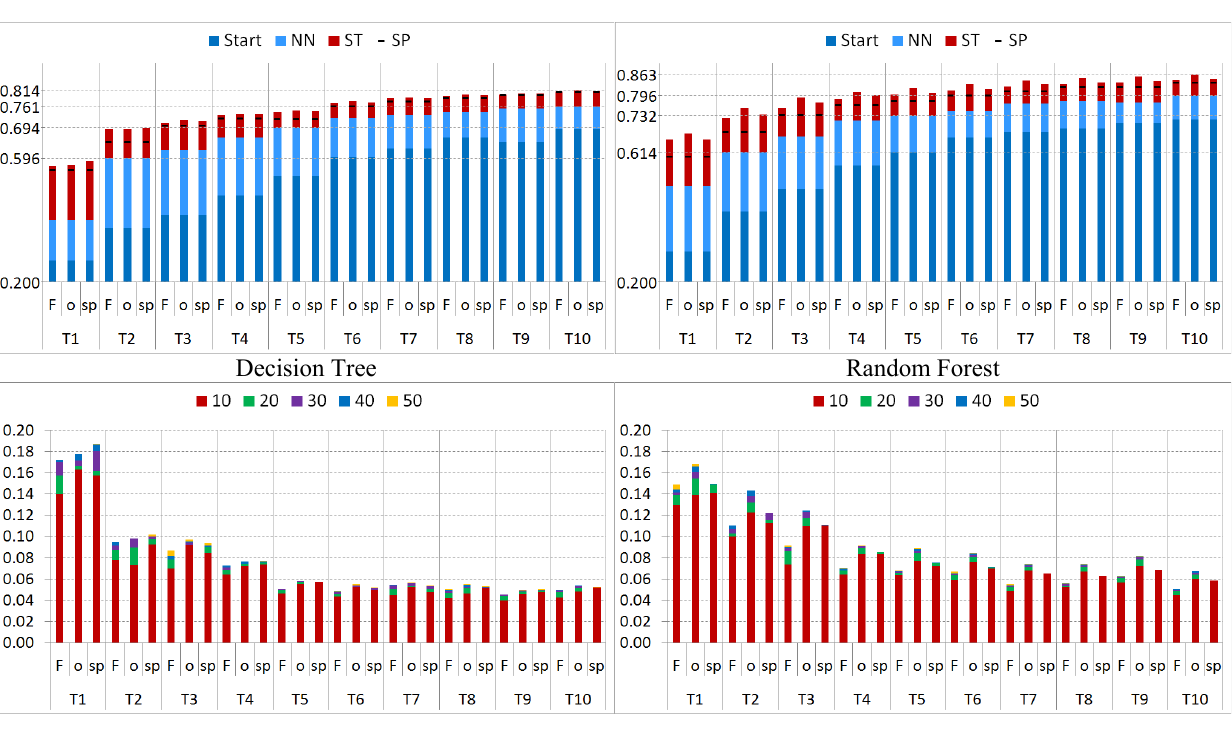
Figure 13. Top row: Classification accuracies for different training sets, NN three selection methods for the unlabeled samples. Dashed lines show results for enlarging T superpixel (SP). Bottom row: Improvements of self-training per 10th iteration for the two i base learners. The selection methods are abbreviated as F ( full ), o (NH